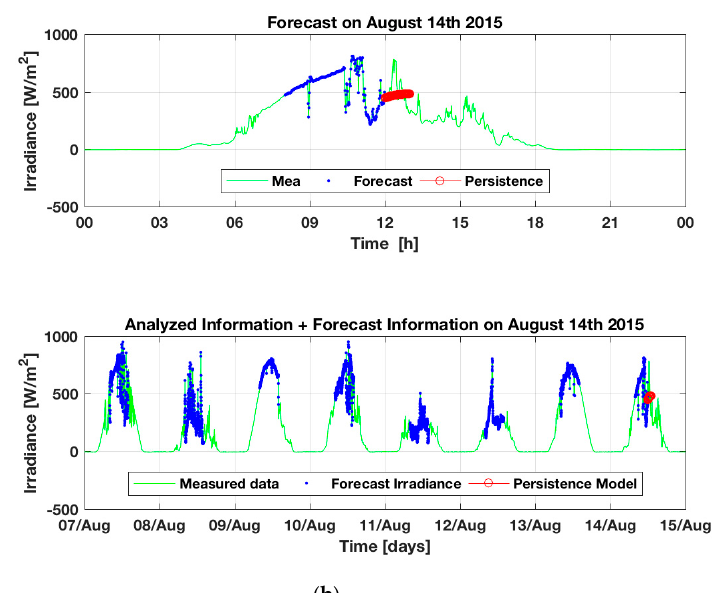
Figure 3. Prediction from the reference persistence model for two different days: ( a ) 18 September 2014 from 14:01 to 15:00. ( b ) 14 August 2015 from 12:01 to 13:00. The red dots on the lower part of both images indicate the simulated time. The blue dots indicate that the data employed for the simulation was one hour previous to this from the last seven days. The upper part shows a zoom of the simulation day.